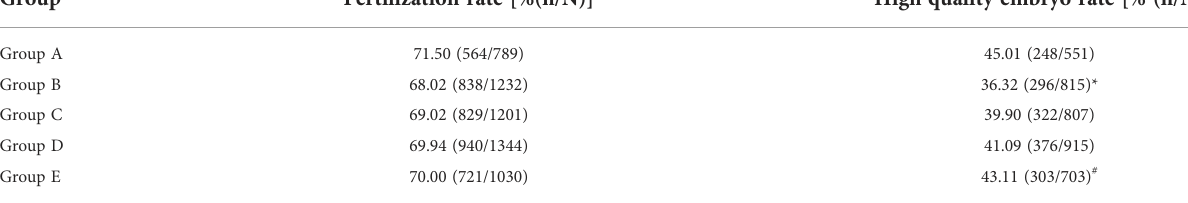
TABLE 6 Embryology